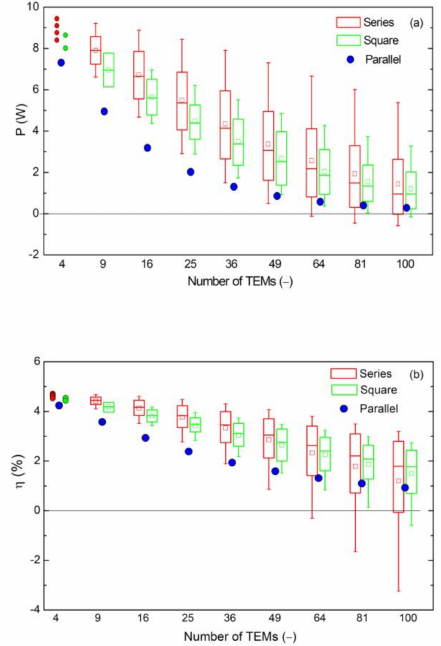
Figure 5. Box chart of ( a ) output power P and ( b ) energy conversion efficiency η datasets for series, square and parallel configurations for ATEGs using different number of TEMs ( n TEM from 4 to 100). Whisker ends correspond to maximum and minimum values of the dataset. The hollow square corresponds to the average value of the